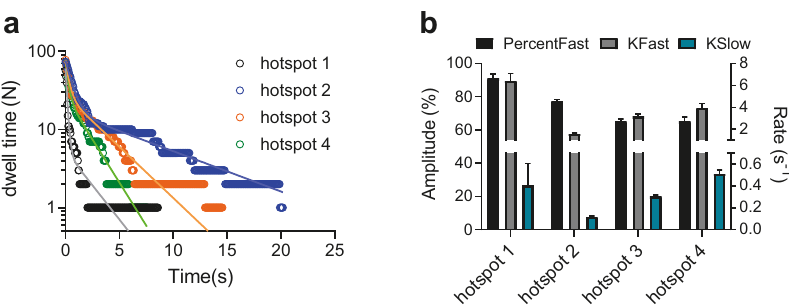
Fig. 4 Cumulative dwell time distributions recorded from different individual actomyosin hotspots to illustrate the heterogeneity in time constants. a Cumulative frequency distributions of Alexa-nucleotide dwell time events comparing actin-activated ATPase activity from four different hotspots. Data are fi tted with double-exponential functions. b Amplitudes and rate constants obtained from fi ttings to data in a . Note that from the individual actomyosin hotspots only two processes attributed to actin-activated ATPase and “ unexplained ” phase can usually be resolved, while basal myosin ATPase remains obscured. For hotspot 2, it seems likely that the binding site of the HMM molecule is unfavorable for actin attachment, explaining a high ratio of basal